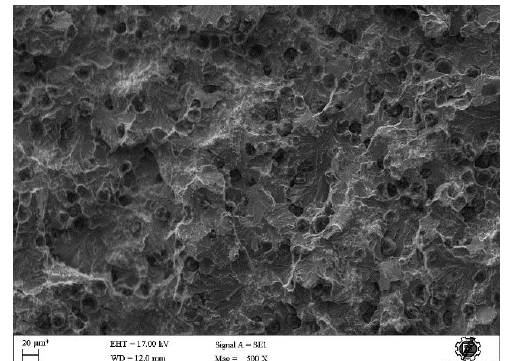
Figure 38. Fractured surface of Ni.